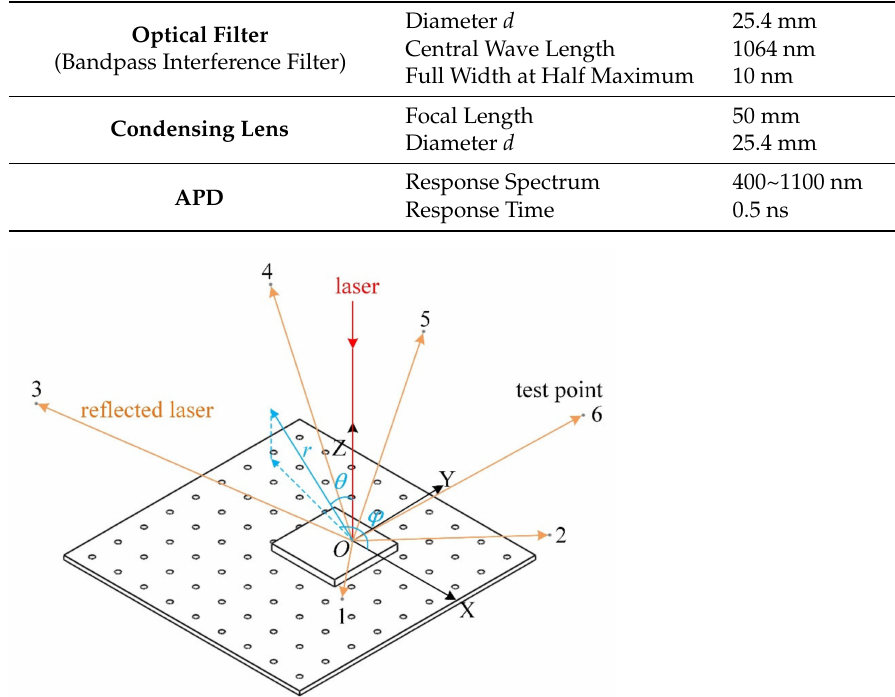
Table 2. Characteristics of radiation intensity sensor.